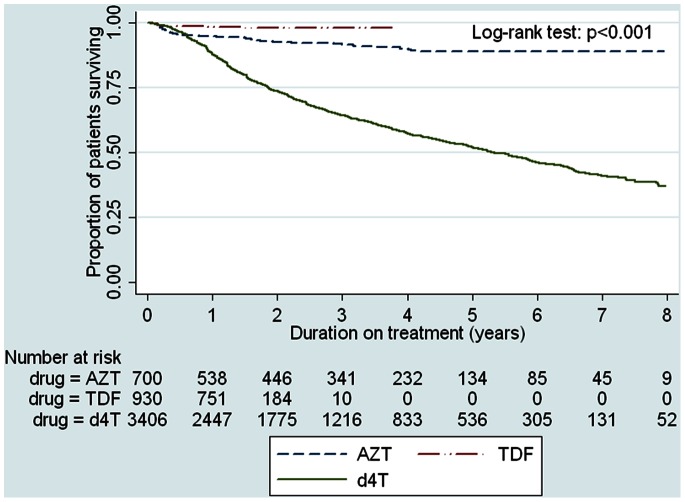
Kaplan-Meier estimates of time to first drug substitution due to ADRs in d4T, AZT and TDF.